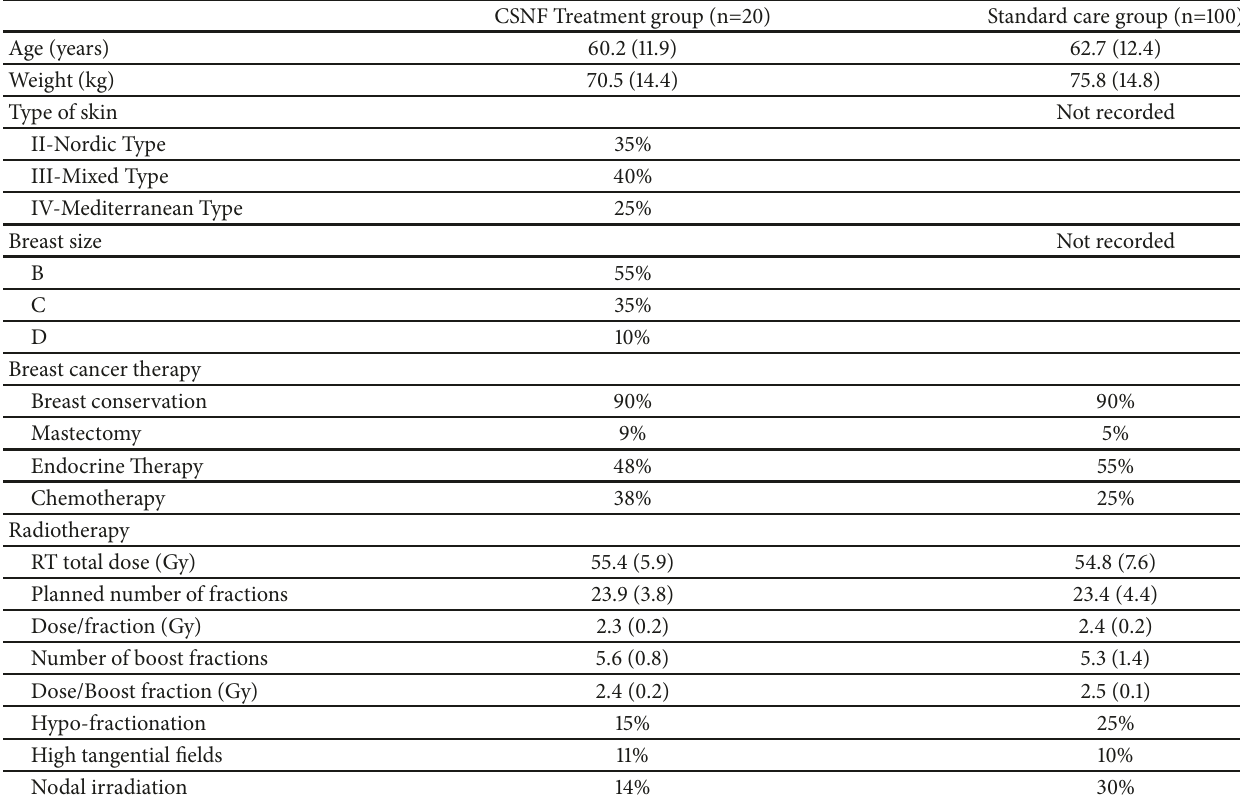
Table 1: Demographics, status, and therapy of breast cancer and